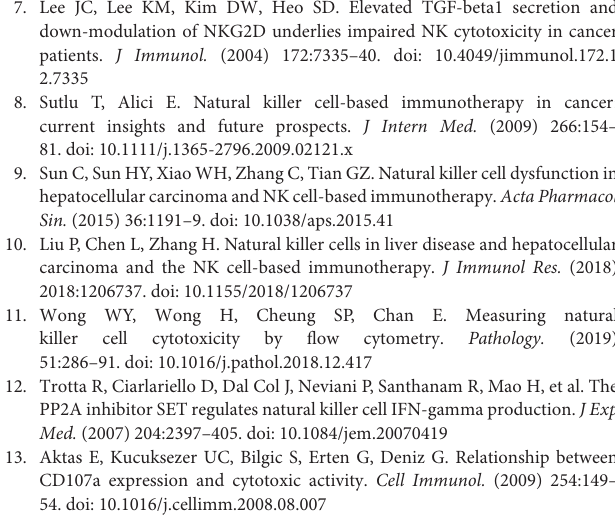
Table S1 | Performance characteristics of the NK cytotoxicity assay based on PBMCs or